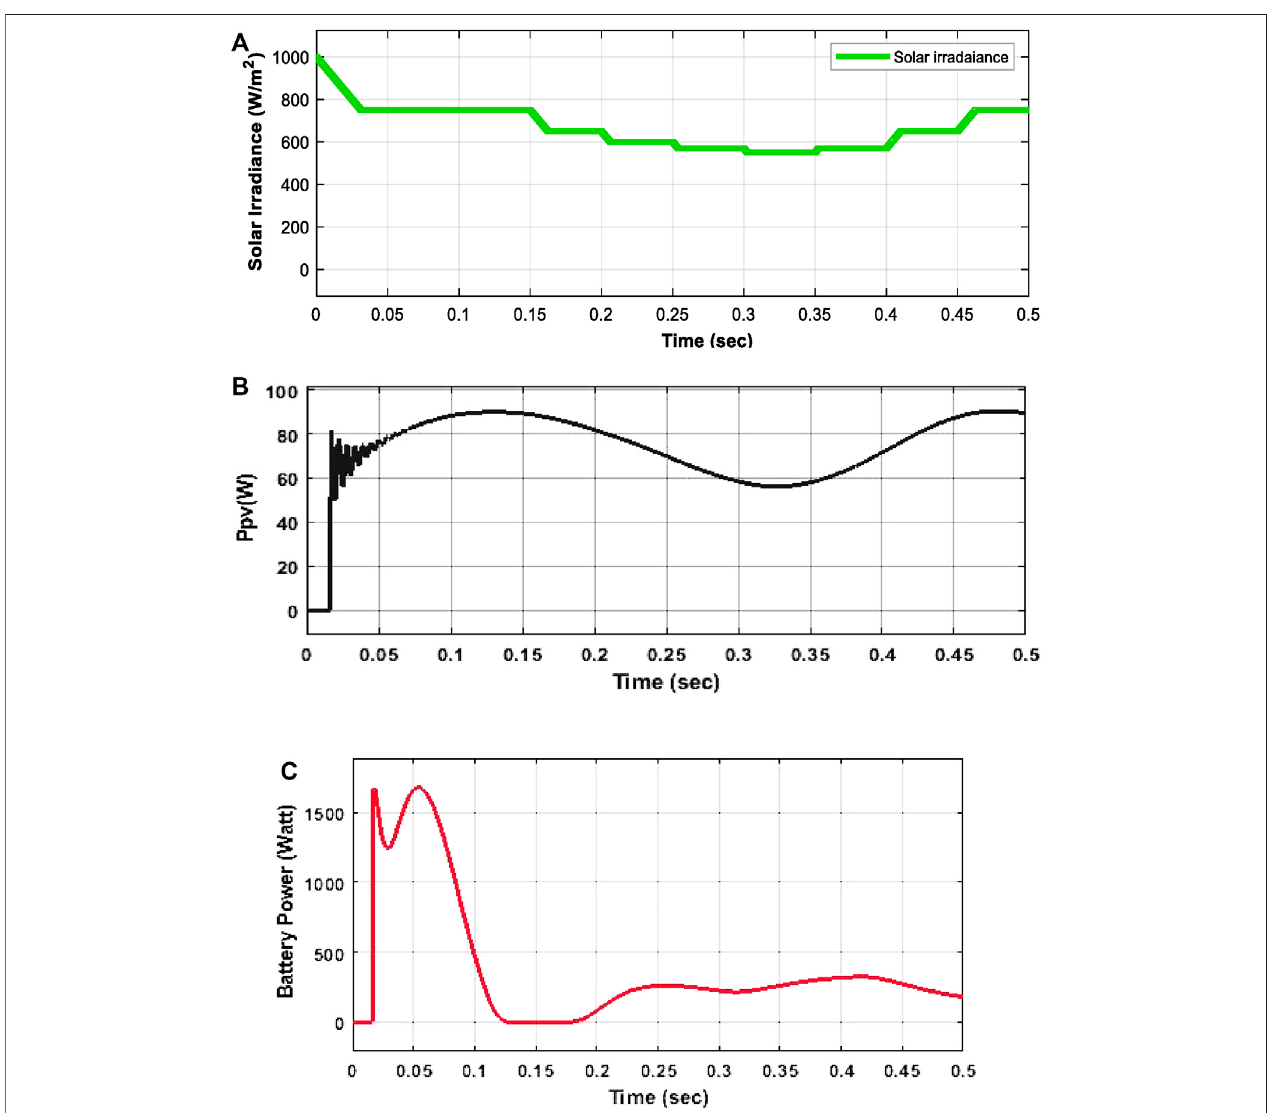
FIGURE 13 | (A) Solar irradiance pattern (in W/m 2 ). (B) Power of the solar PV module. (C) Battery power.